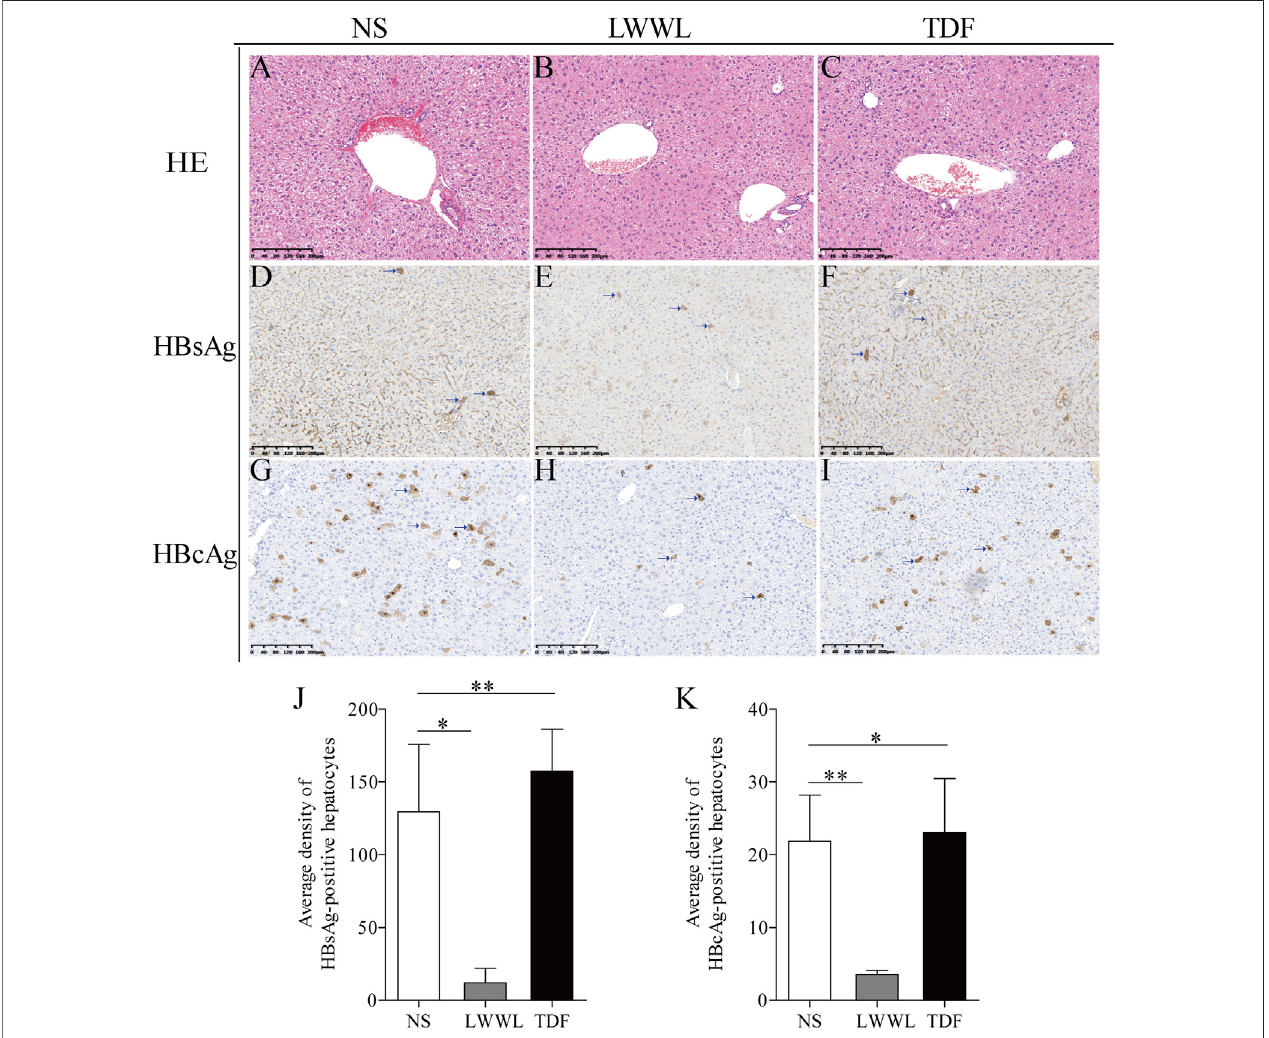
FIGURE 4 | Histopathological examinations of LWWL-treated pAAV-HBV1.2 replication mice. HE was conducted for liver analysis of (A) NS-, (B) LWWL-, and (C) TDF-treated mice, respectively. Immunohistochemistric staining was conducted for HBsAg levels in liver of (D) NS-, (E) LWWL-, and (F) TDF-treated mice. Immunohistochemistric staining was conducted for HBcAg levels in liver of (G) NS-, (H) LWWL-, and (I) TDF-treated mice. Brown indicates the HBsAg- and HBcAg-positive hepatocytes. The quantitative analyses of (J) HBsAg expression and (K) HBcAg expression were also conducted in hepatocytes of NS-, LWWL- and TDF-treated mice. HE, Hematoxylin and eosin staining; NS, normal saline; LWWL, Liuweiwuling Tablet; TDF, tenofovir disoproxil fumarate. * p < 0.05, ** p < 0.01.